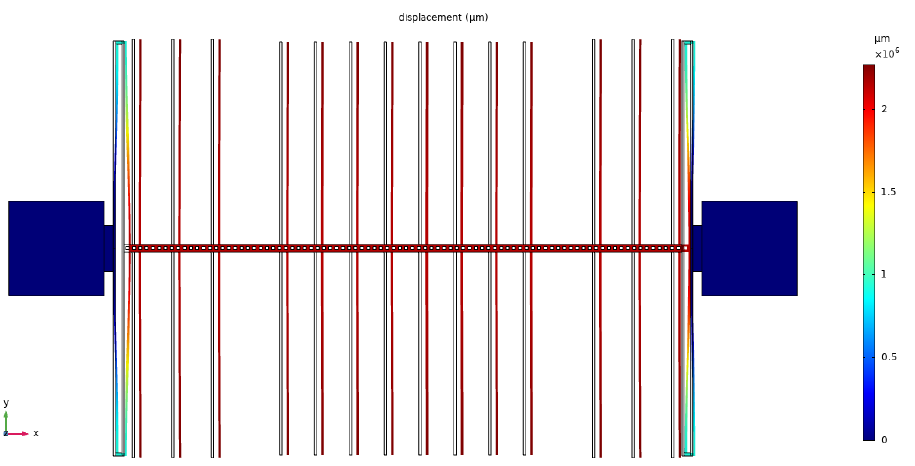
Figure 6. First-order resonant mode of the microsensor by simulation. Displacement is magnified for clear display in COMSOL. clear display in